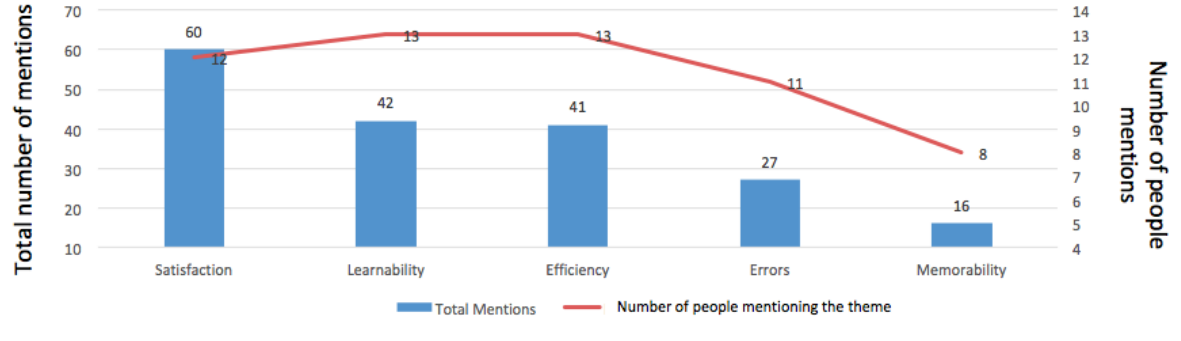
Figure 6. Usability overview from mHealth insiders.